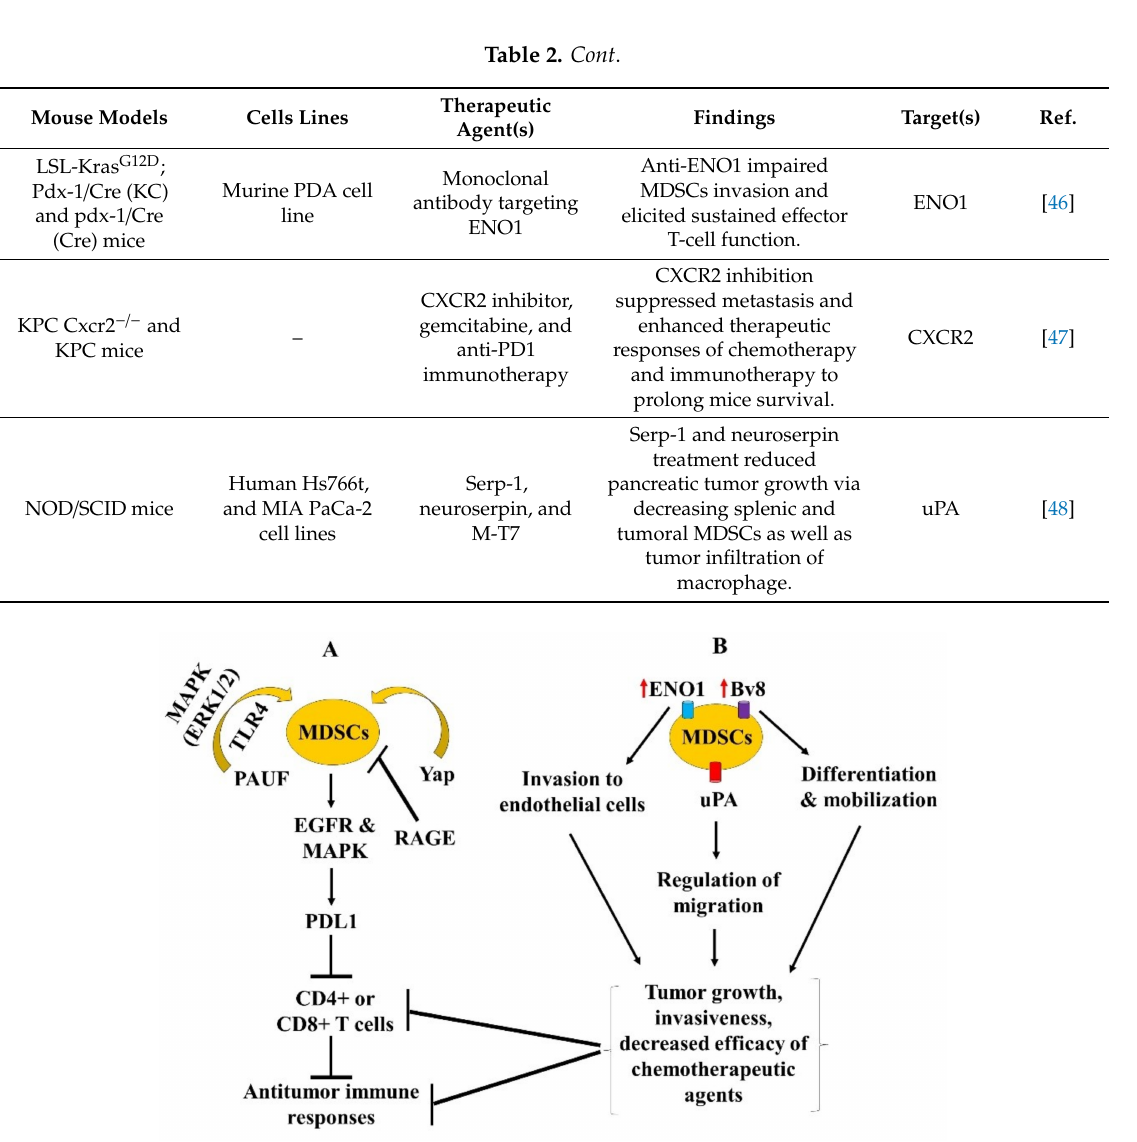
Figure 3. Schematic representations of A) other signaling pathways and B) factors involved in the regulation of MDSCs di ff erentiation, accumulation, migration and function. The mediators (i.e., cytokines, chemokines, angiogenesis and immune cells) involved in the context of these pathways or factors, have been summarized in the text and also included in Figure 2, thus, are not repeated here. The sign → denotes induction or regulation, inhibition and increase or